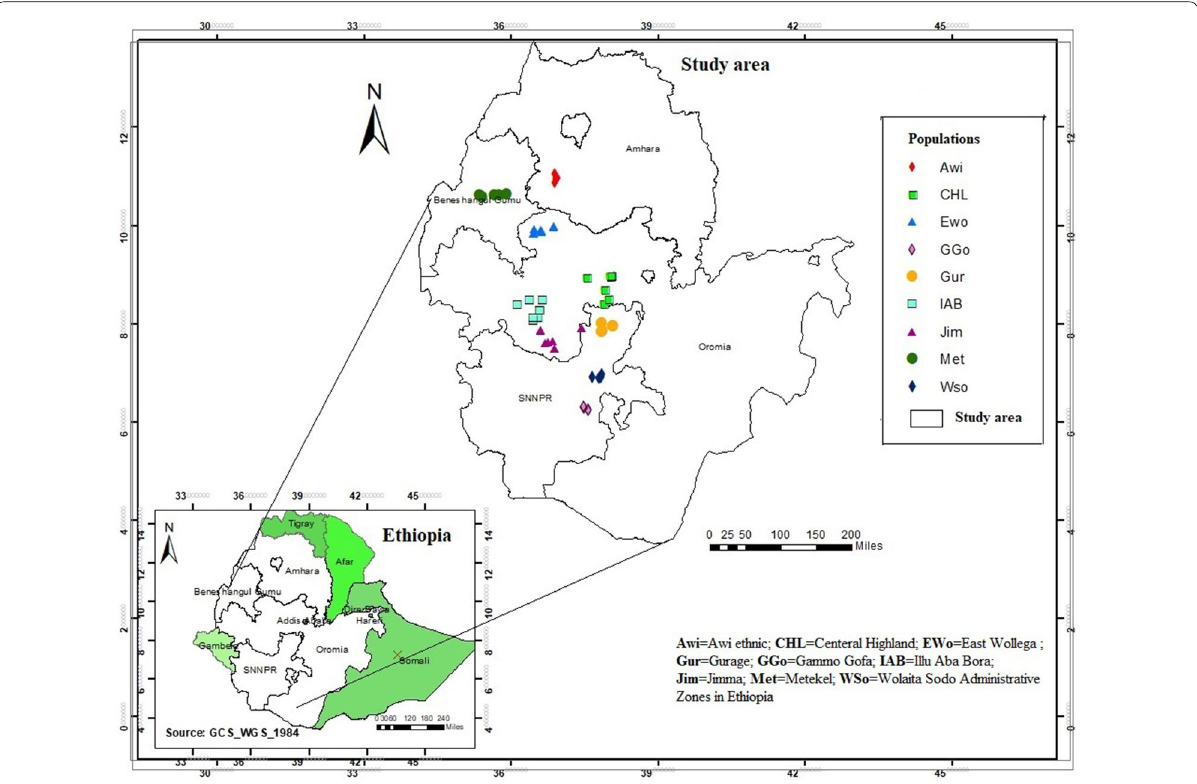
Fig. 1 A map of Ethiopia with federal administrative regions (left down) showing P. edulis accessions collection administrative regions (left up). The map was constructed based on geographic coordinates and elevation data gathered from each collection sites using global positioning system